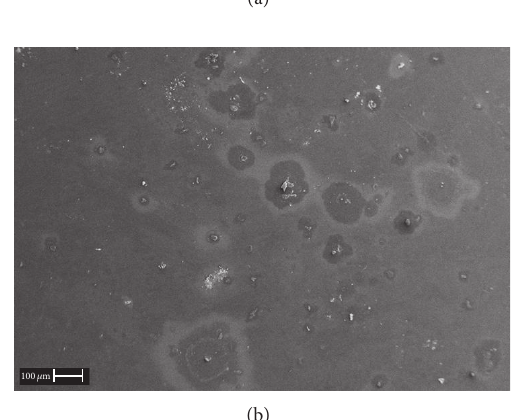
CH2 and CH3 deformation. Spectrum 1 corresponds to the area without degradation (Figure 4). e bands were gener- ally better de�ned than in the points without